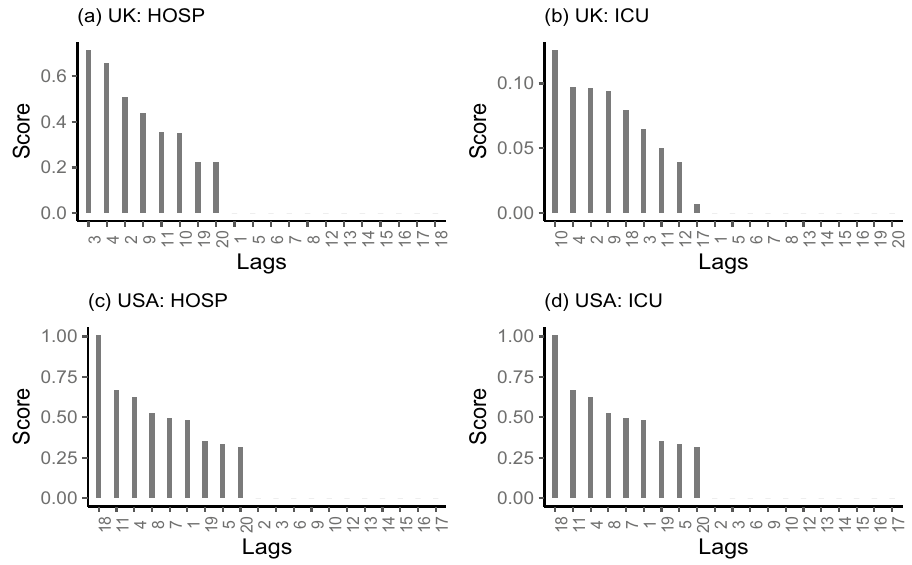
Figure 5. Average feature importance scores computed from 500 replications of RT model of (cid:31) HOSP t and (cid:31) ICU t for distributed lags of (cid:31) VAC t − k in USA and UK, where k = 1, . . . , 20